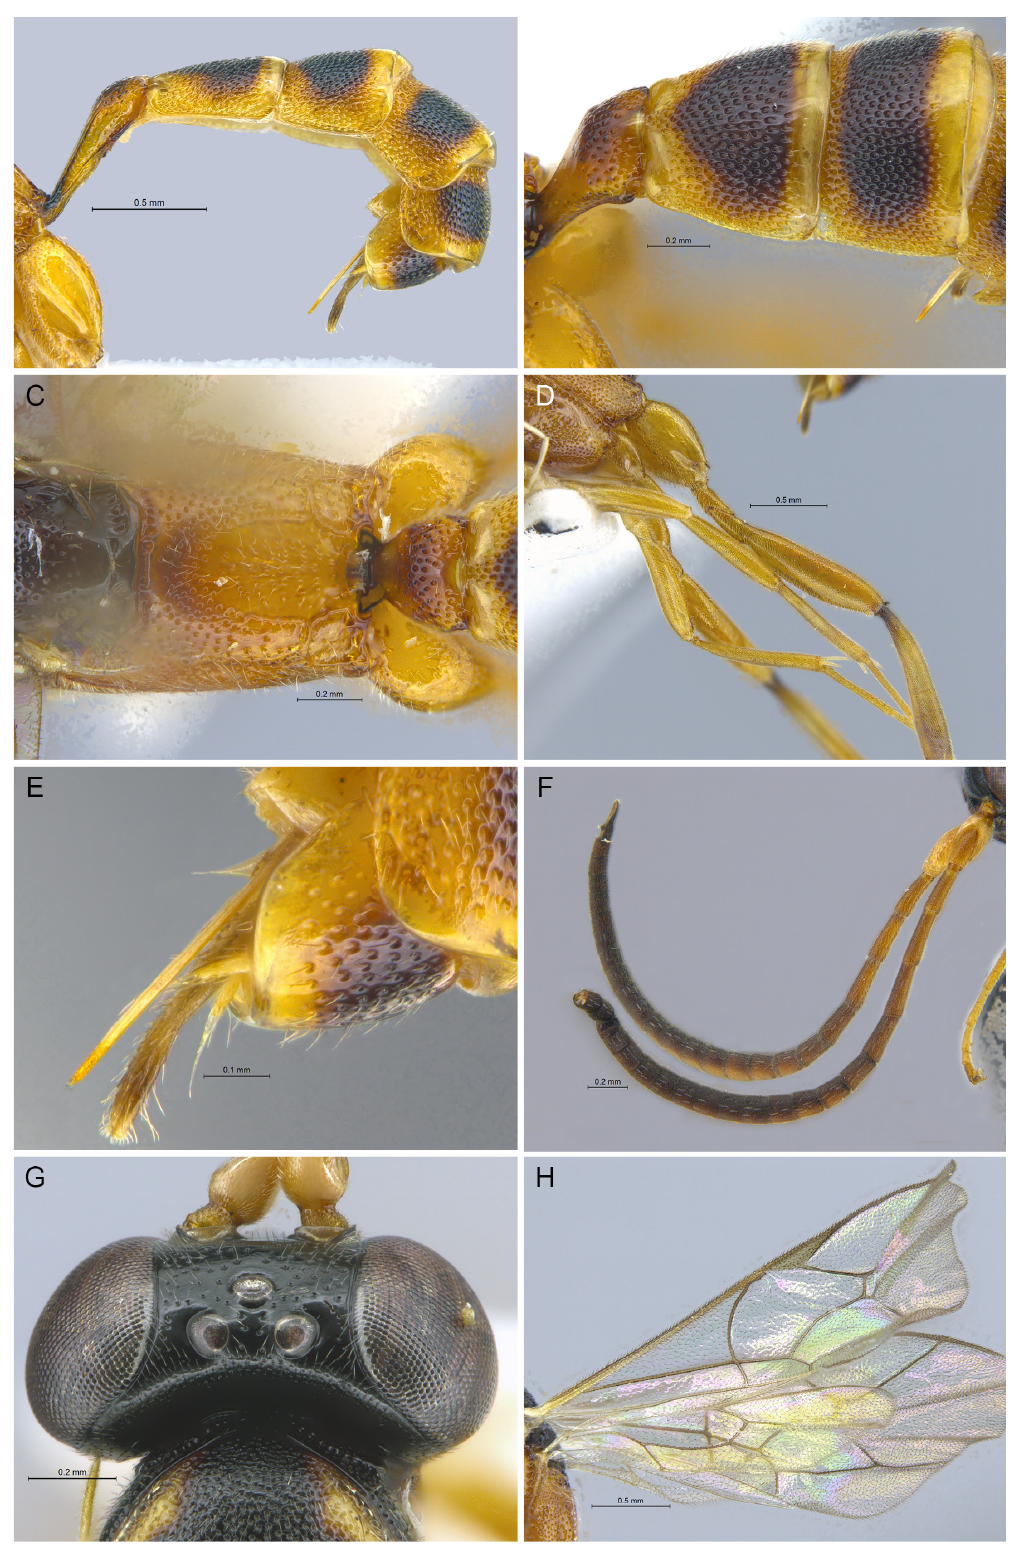
Fig. 21. Palpostilpnus trifolium sp. nov., holotype, ♀ (NHRS HT-HEVA000010861). A . Metasoma, dorsal view. B . T2–T3, dorsolateral view. C . Propodeum, dorsal view. D . Hind leg. E . Ovipositor. F . Antenna. G . Vertex. H .